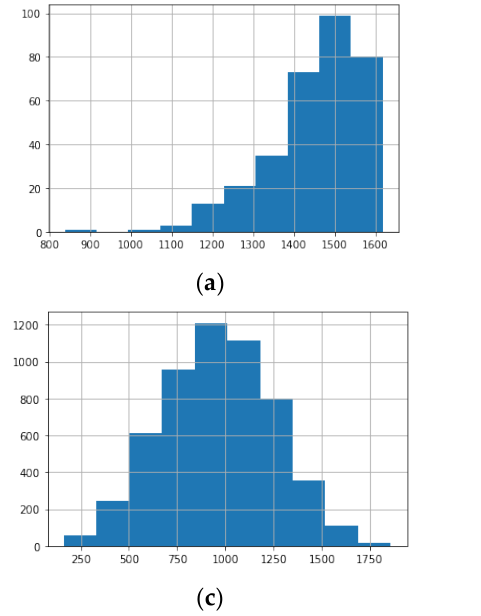
Figure 2. ( a ) Histogram of sleep habit scores for good sleep using a logistic regression model; ( b ) histogram of sleep habit scores generated for bad sleep data; ( c ) histogram of sleep habit scores for good and bad sleep data combined.